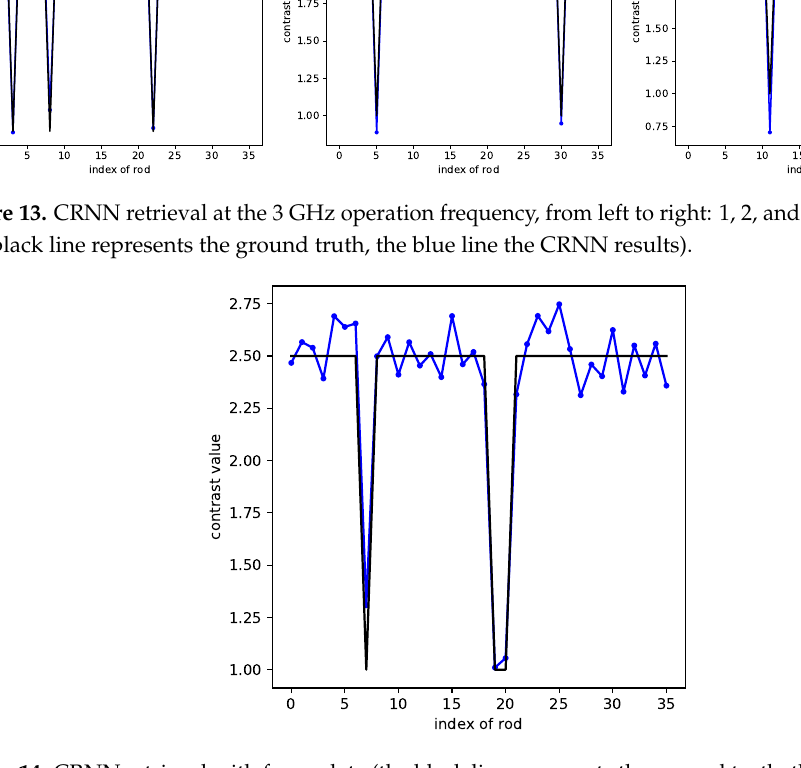
Figure 14. CRNN retrieval with fewer data (the black line represents the ground truth, the blue line the CRNN results).